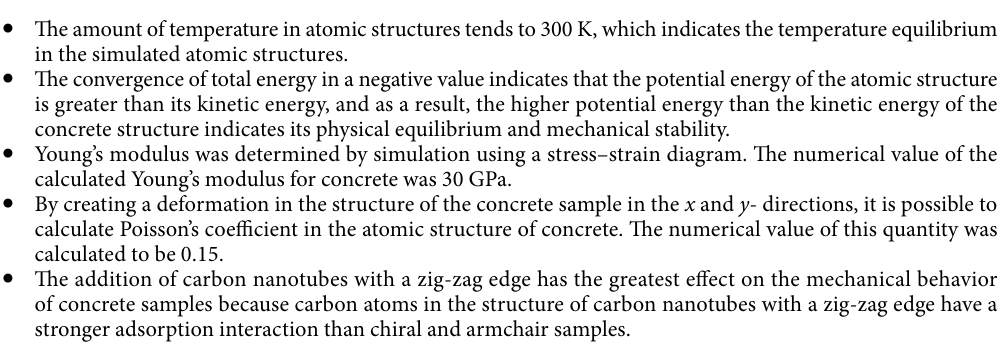
Table 2. Calculated mechanical properties for concrete matrix specimens using molecular dynamics method.